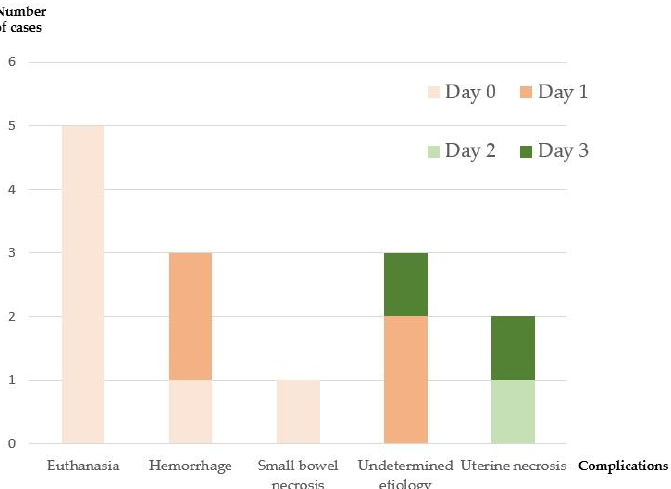
Figure 6. Description of the complications found in the 14 ewes of the third series. Each ewe had only one complication. Ewes that died of non-vascular causes were excluded from the short-term analyses (all except for those that died of uterine necrosis). Day 0 = day of the intervention, Day 1 = 1st postoperative day, Day 2 = 2nd postoperative day, Day 3 = 3rd postoperative